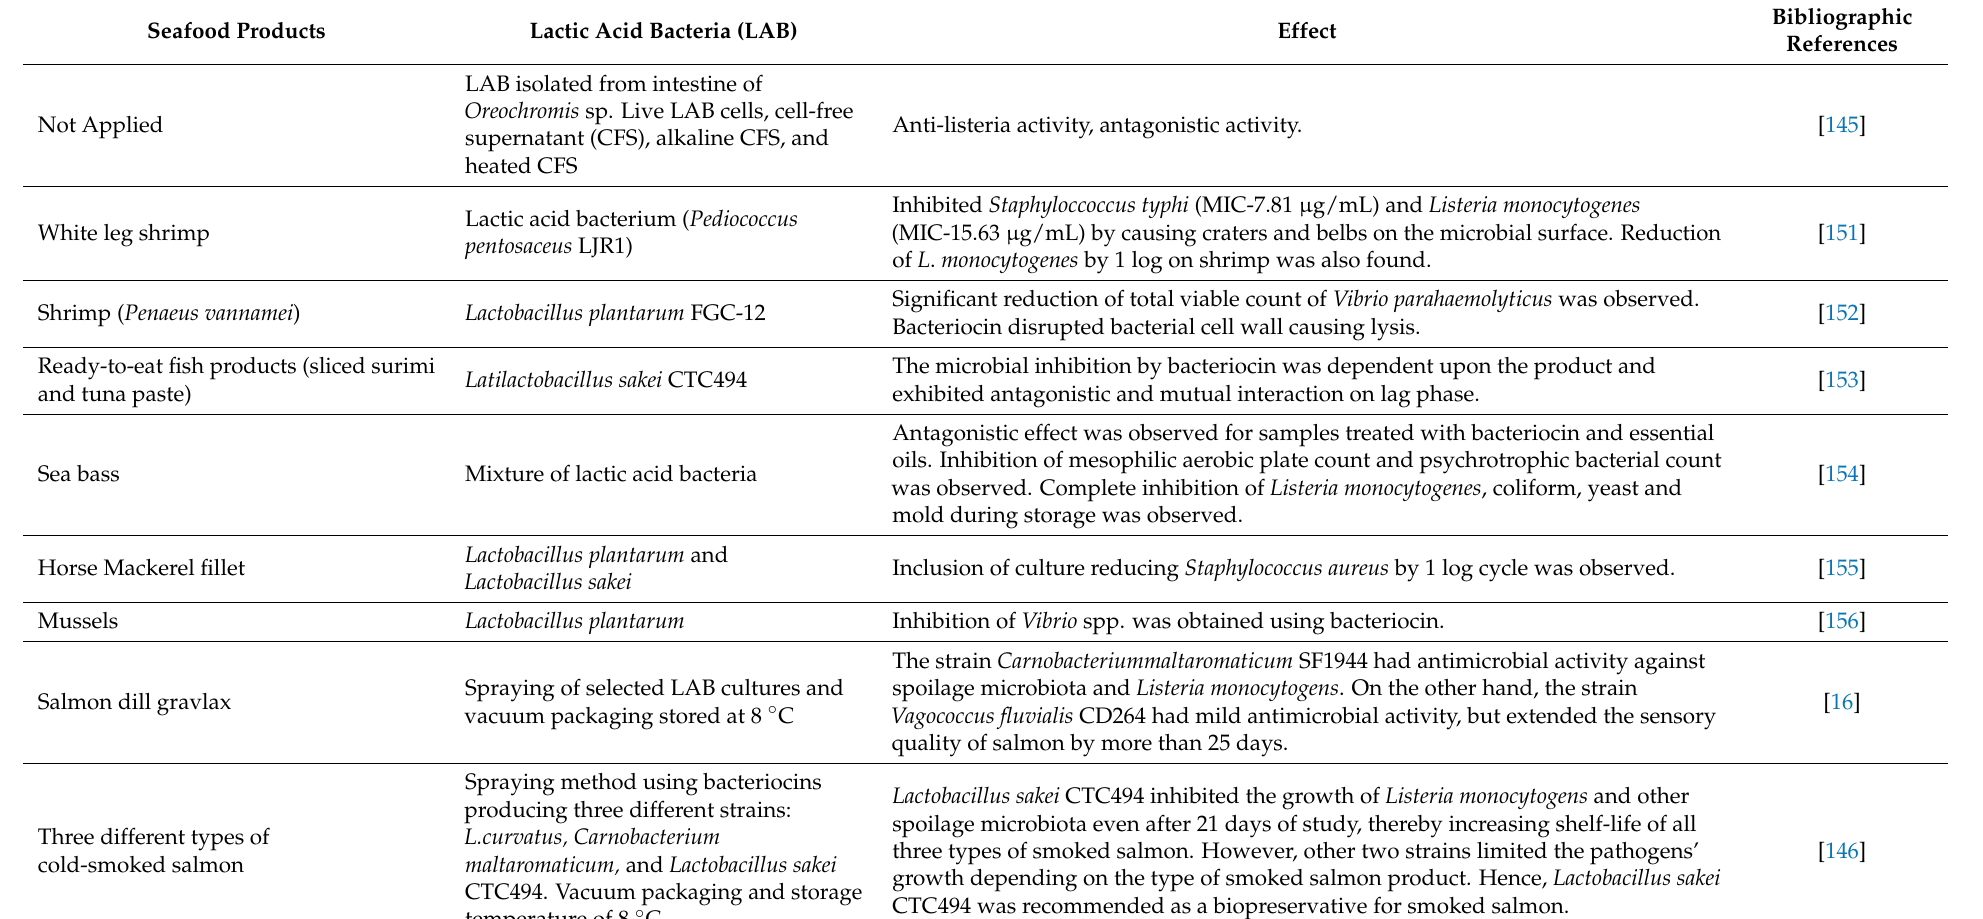
Table 2. Application of lactic acid bacteria (LAB) and derived metabolites in seafood products’